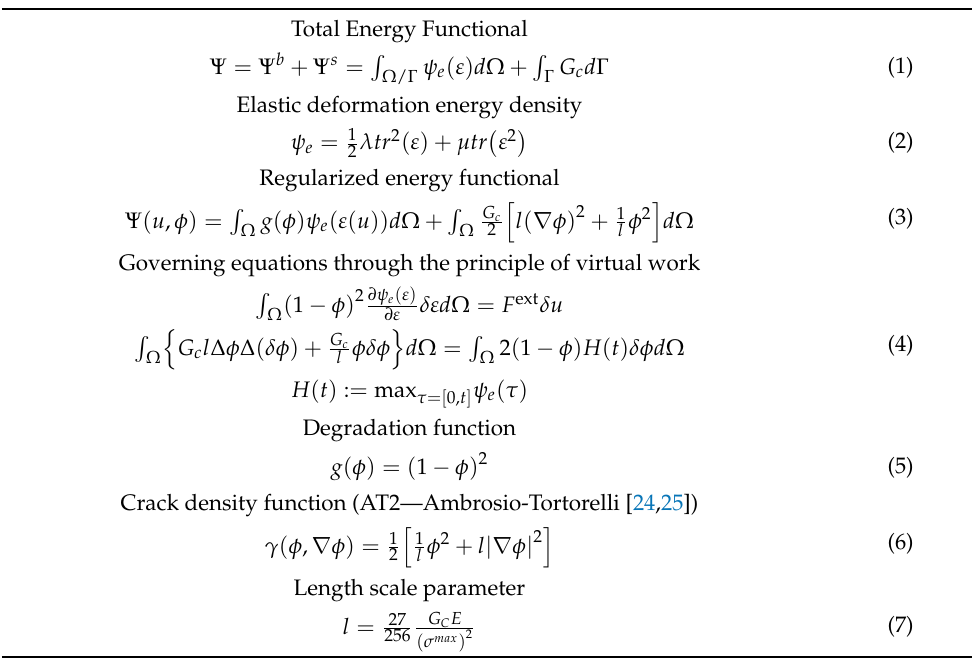
Table 2. Basic equations of brittle phase-field